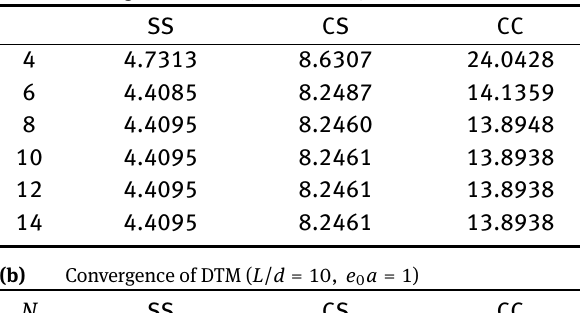
Table 3: Convergence of both DQM and DTM approach (a) Convergence of DQM ( L / h = 10, e 0 a = 1) SS CS